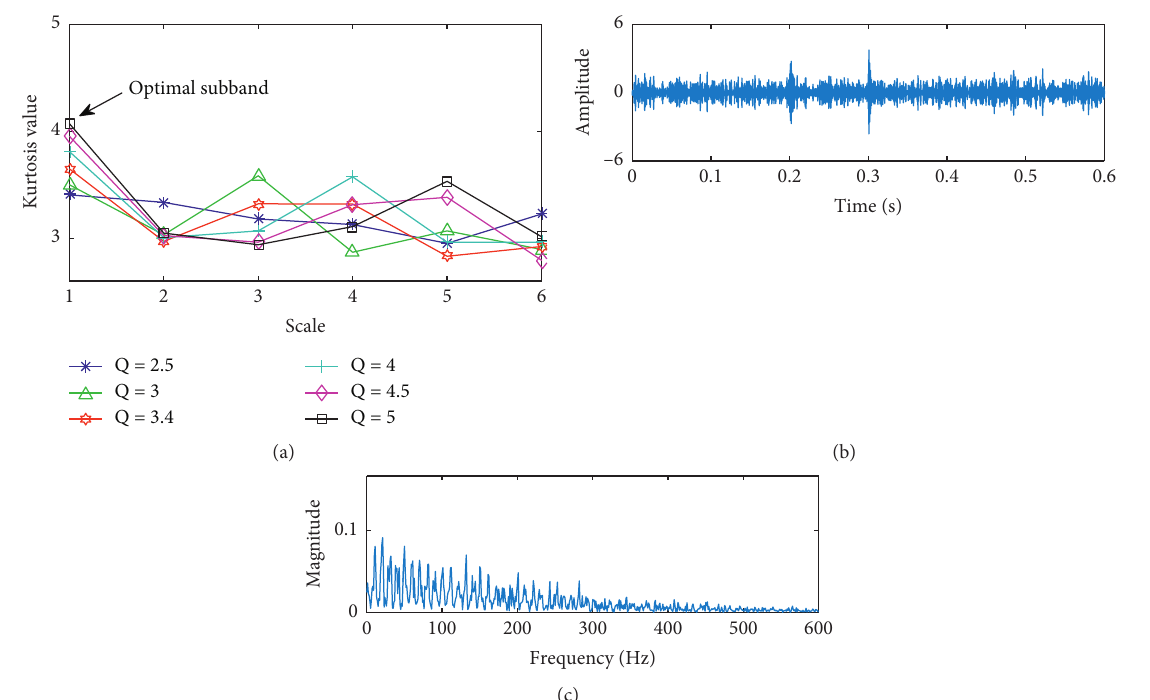
Figure 8: (a) Kurtosis-guided TQWT method, (b) time-domain waveform of the optimal subband, and (c) envelope spectrum of (b).